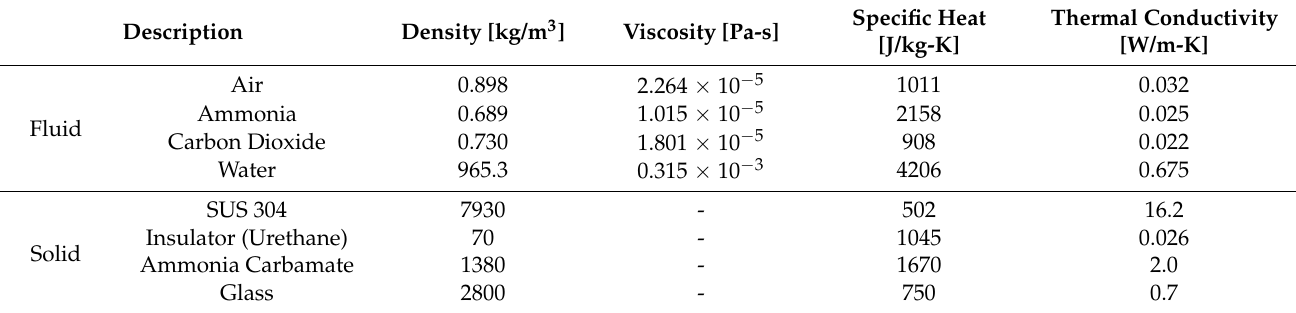
Table 1. Physical properties of working fluid and